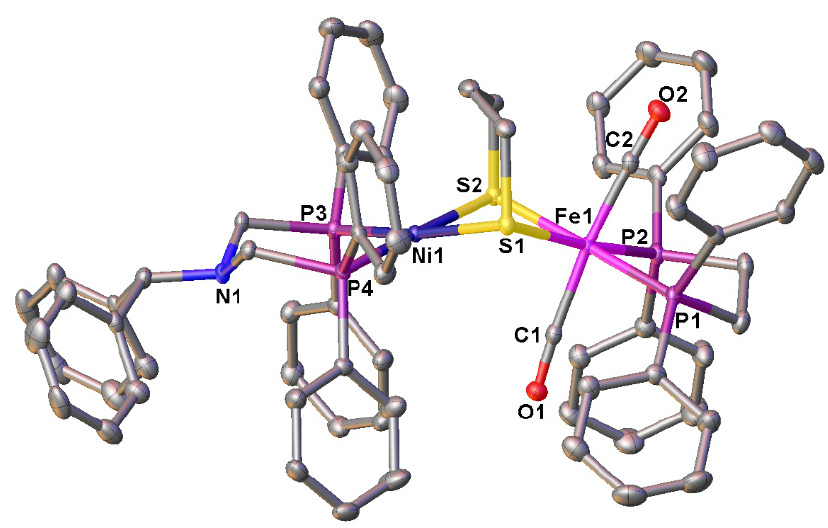
Figure 7. Molecular structure of [ D ](BF 4 ) 2 with thermal ellipsoids drawn at a 30% probability level. All H atoms and two BF 4 − anions are omitted for the sake of clarity. Selected bond lengths (Å) and angles ( ° ): Ni ⋅⋅⋅⋅ Fe 3.2957, Ni1-S1 2.2409(9), Ni1-S2 2.2329(9), Fe1-S1 2.3456(9), Fe1-S2 2.3013(9), Fe1-